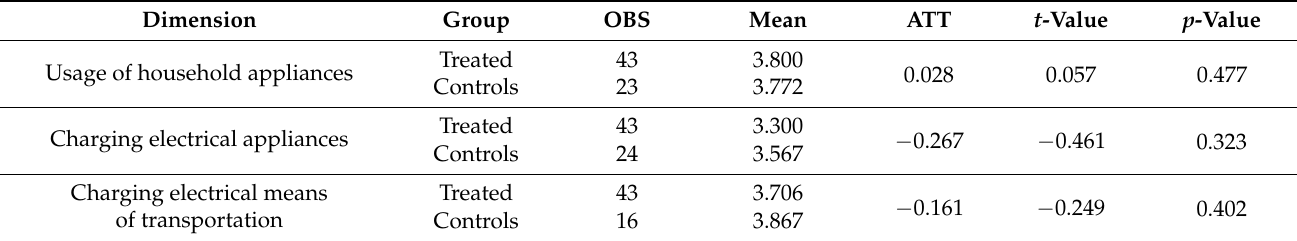
Table 12. Demand flexibility comparisons of Solar-sellers (treated) versus Solar-consumers (controls) (source: authors’ own